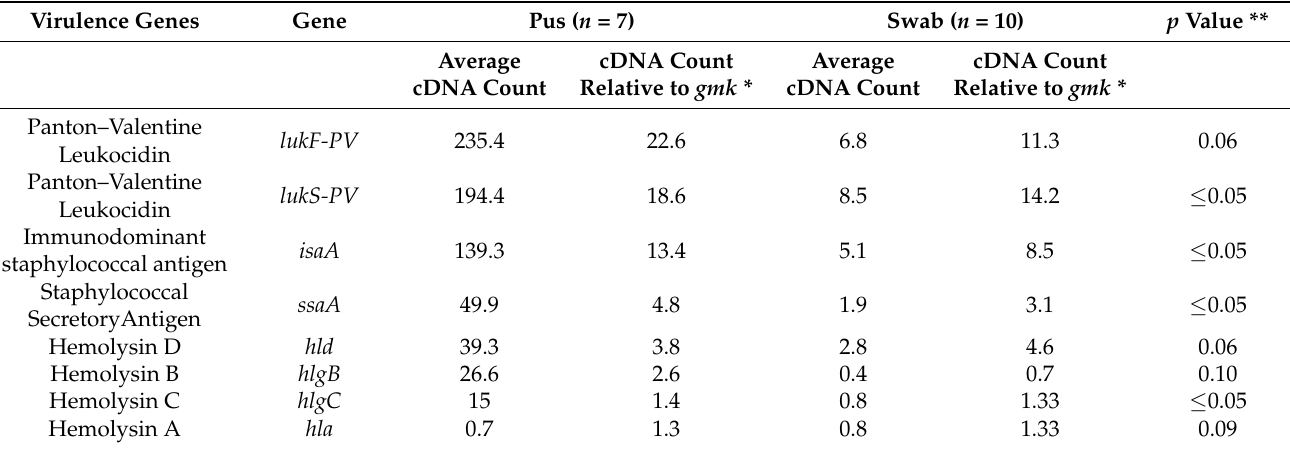
Table 2. The average cDNA count of the virulence genes from pus or swab samples and their relative cDNA count to that of gmk